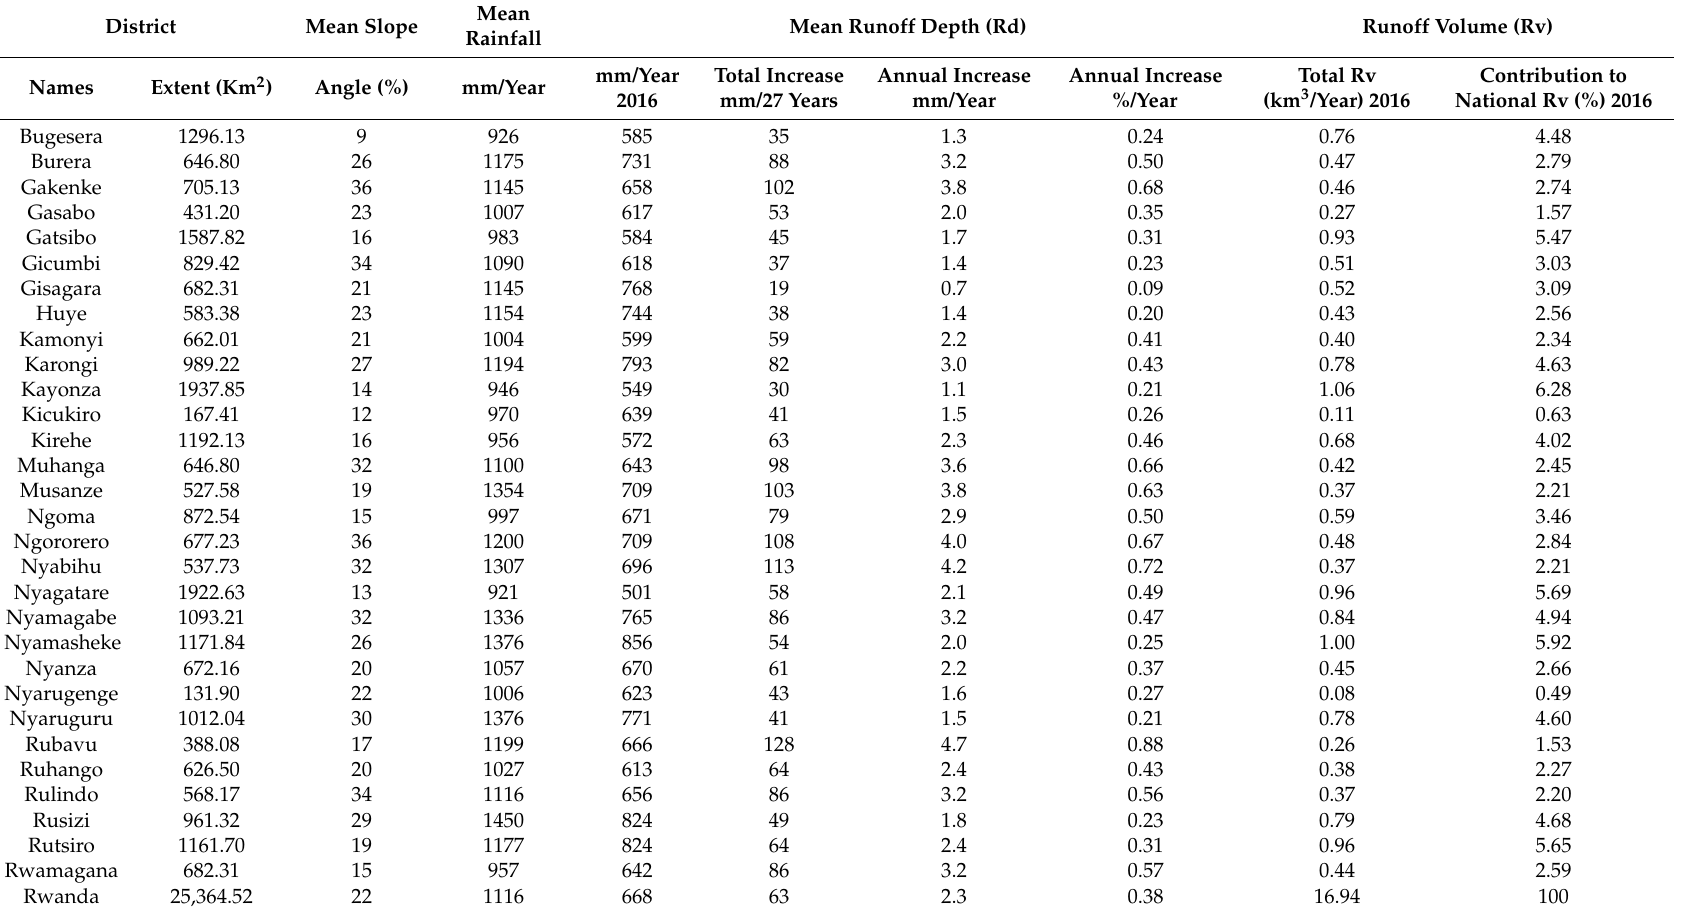
Table 6. Analysis of annual runoff depth and runoff volumes at district